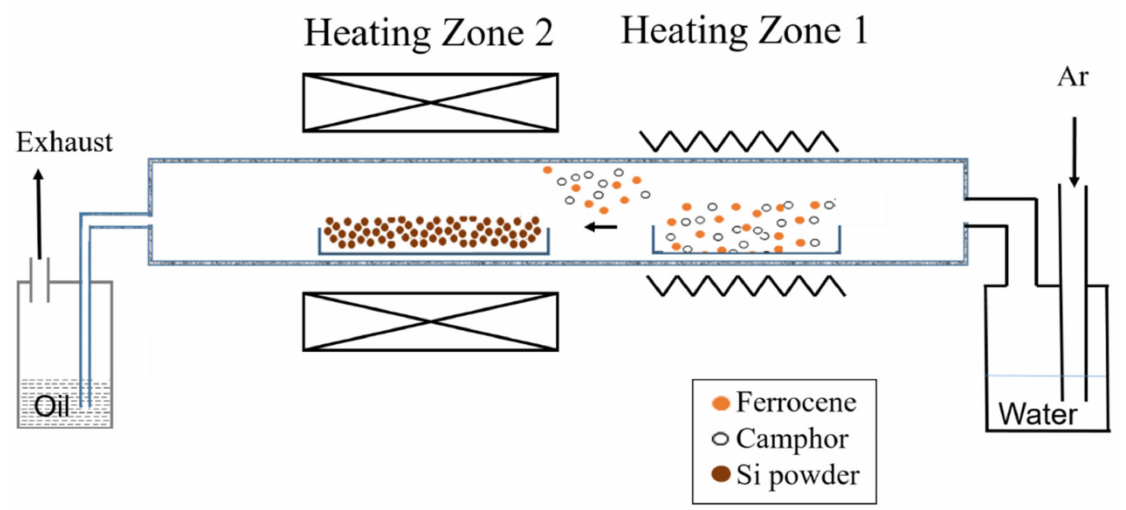
Figure 1. Schematic diagram of a thermal chemical vapor deposition (CVD) system for the deposition of conductive nanocarbons on